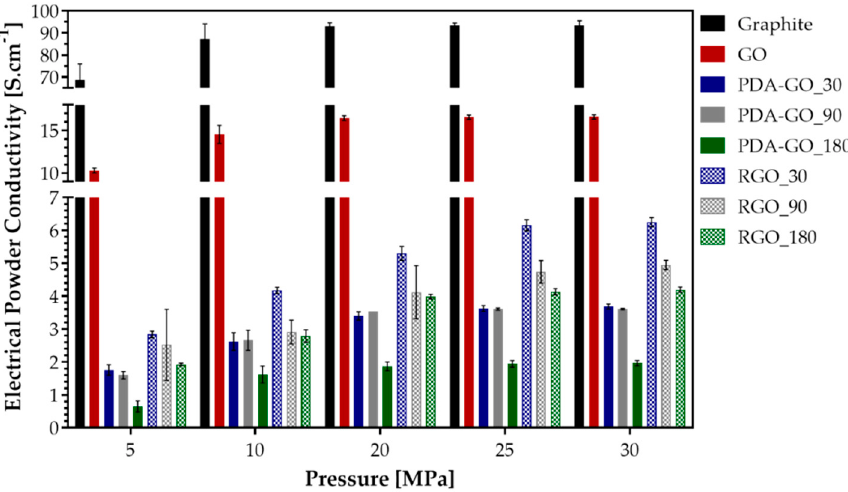
Figure 9. Electrical conductivity of the powdery materials at different pressures.